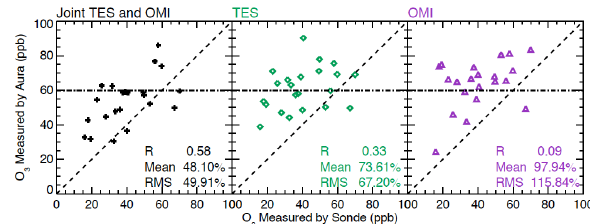
Figure 8 . Correlations of Aura measured and ozonesonde measured ozone concentration in parts-per-billion (ppb) in the region from surface to 700hPa: joint TES and OMI (left panel); TES only (middle panel); OMI only (right panel). For Joint TES/OMI measurements, TES alone and OMI alone, the mean difference is 48.10%, 73.61%, and 97.94%, respectively; the 1 σ standard deviation to the mean difference is 49.91%, 67.20%, and 115.84%, respectively; and the correlation coefficient of R is 0.58, 0.33, and 0.09, respectively. The joint observations have improved the capability of capturing the variations of ozone concentration in the region from surface to 700hPa, compared to TES or OMI observations alone. A common a priori ozone profile (horizontal dash line) was used in the retrievals for all of the scenes. The black dotted dash line indicates one-to-one correlation. The averaging kernels of the Aura measurements were not applied to the ozonesonde measurements.